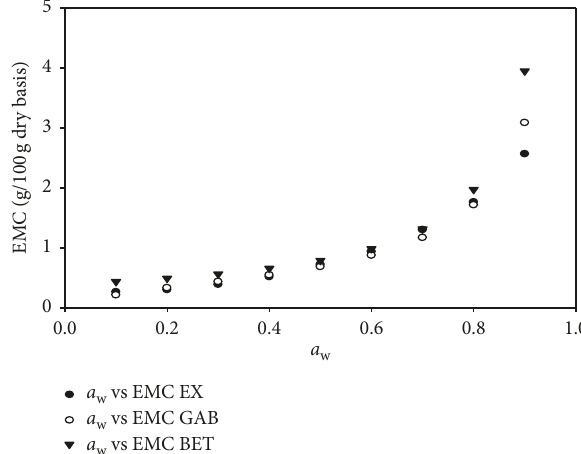
Figure 3: Comparison between experimental, GAB, and BET isotherms of millet flour resin (2% zinc chloride) at 25 °